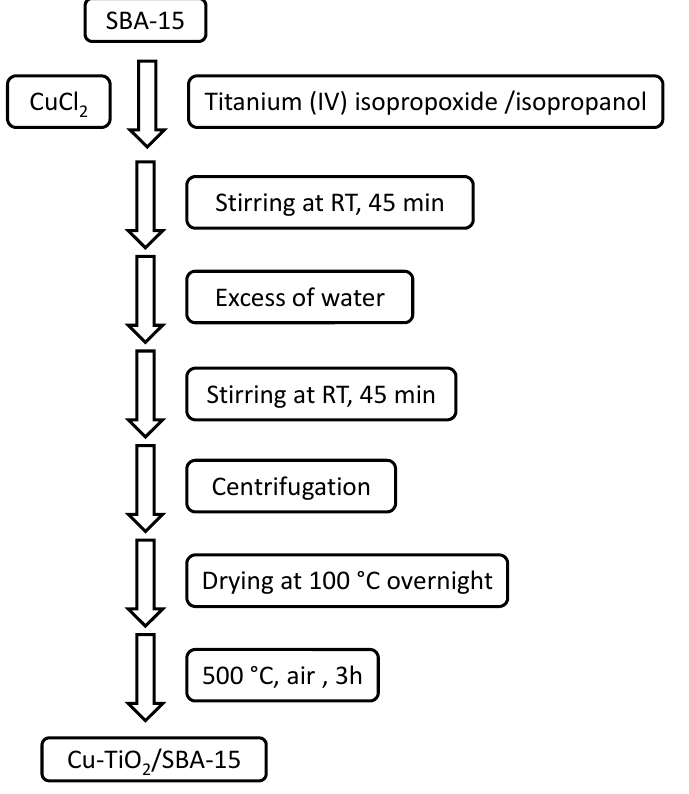
Table 3. Photocatalytic methanol formation rate of various photocatalysts at different irradiation times. The values indicated have been obtained by interpolating data from reference